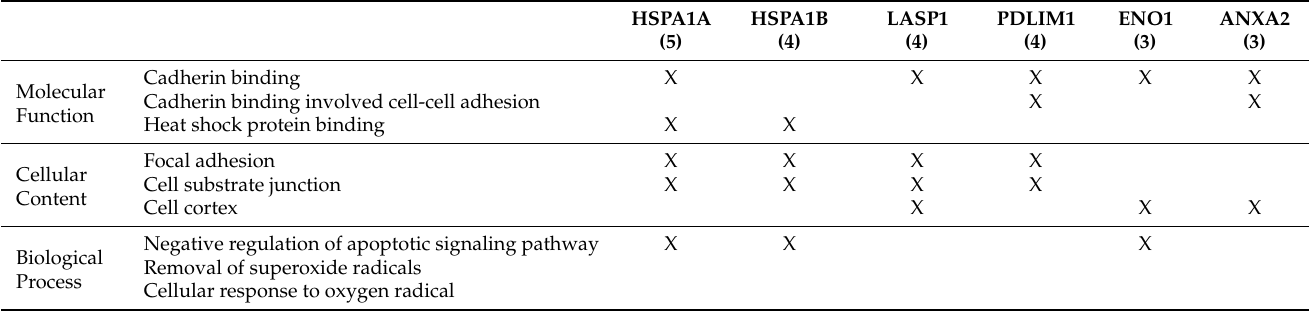
Table 2. Interested Genes for Protein Assessment Involved in Oridonin